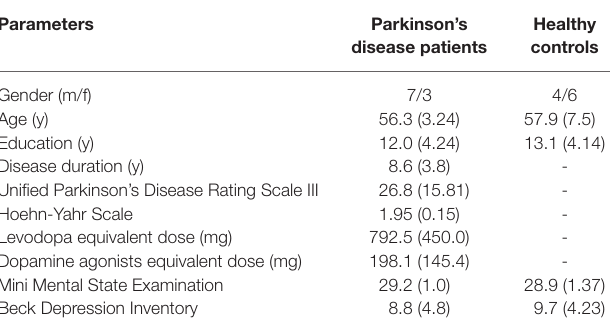
Table represents mean (standard deviation) of clinical and demographic data of Parkinson’s disease patients and healthy